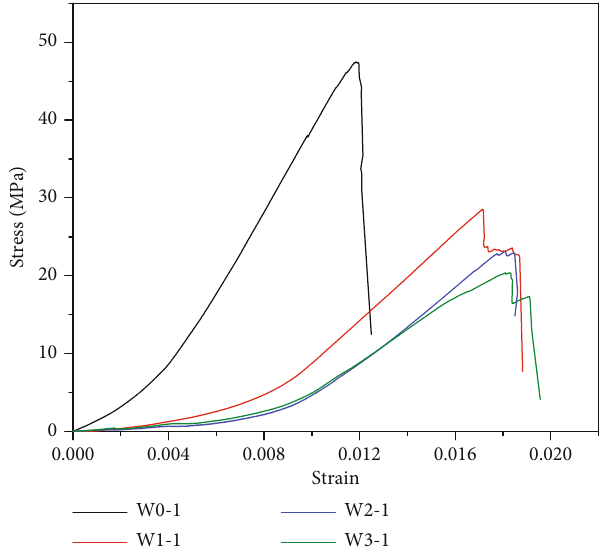
Figure 6: Total stress-strain curve of rock samples with di ff erent moisture